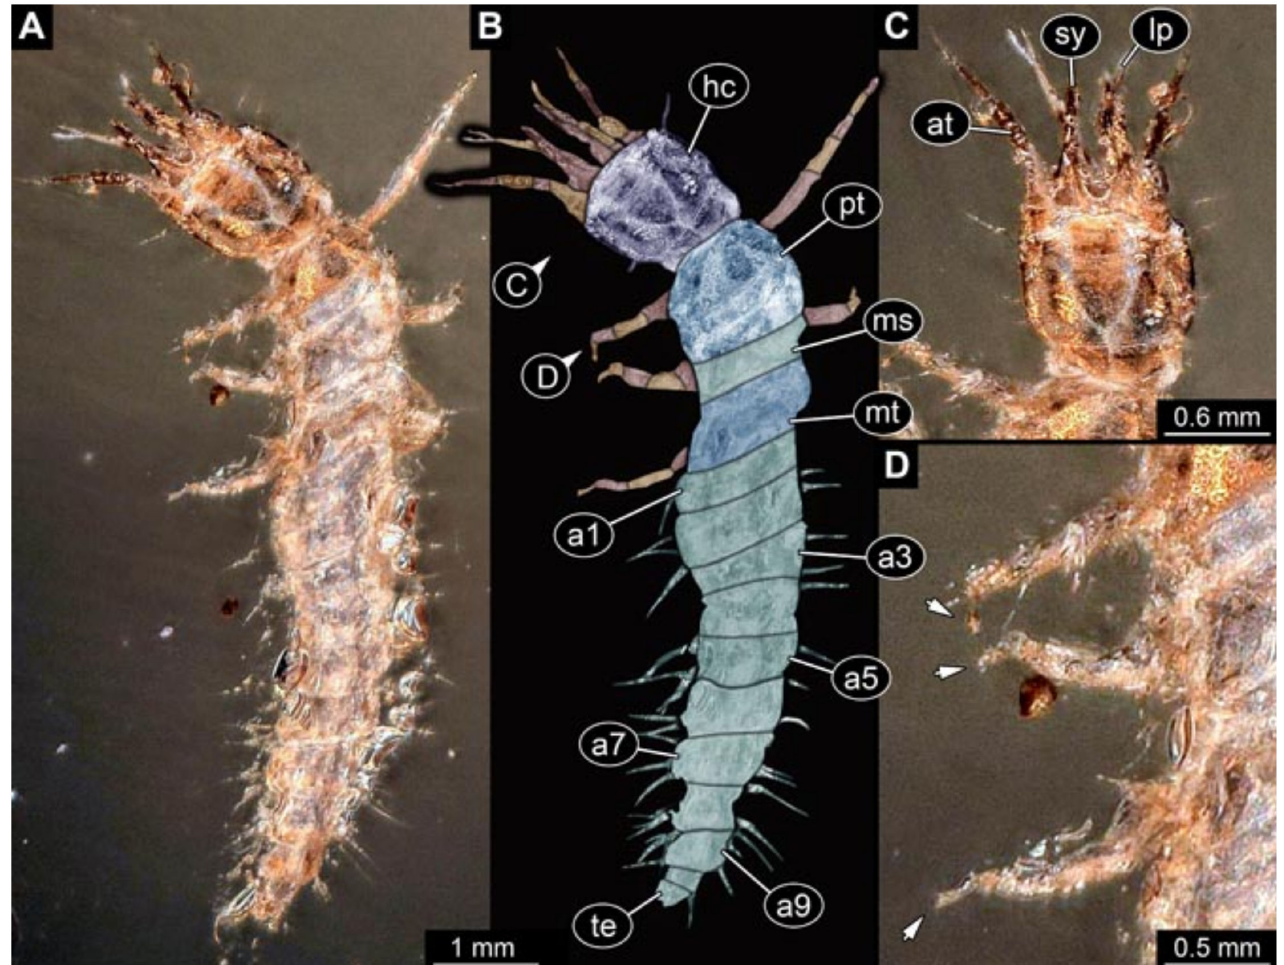
Figure 5. Specimen 5825 (BUB 3065); Myanmar amber. ( A ) Dorsal view. ( B ) Dorsal view, colour-marked. ( C ) Close-up of head capsule in dorsal view. ( D ) Close-up of trunk appendages with empodia (arrows). Abbreviations: a1–a9 = abdomen segments 1–9; at = antenna; hc = head capsule; lp = labial palp; ms = mesothorax; mt = metathorax; pt = prothorax; sy = stylet; te = trunk